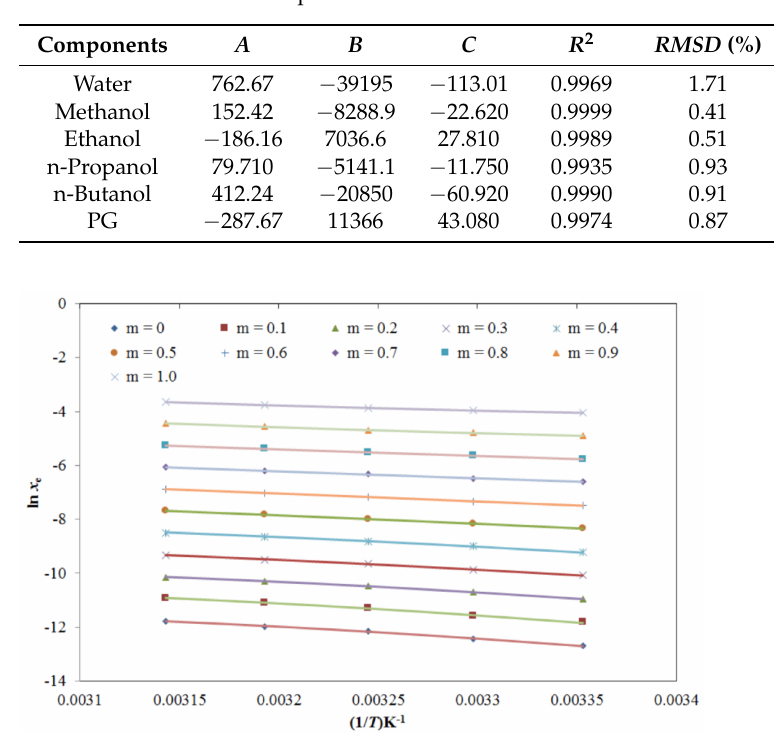
Table 4. The results of the Apelblat model for TRV in six different mono-solvents.